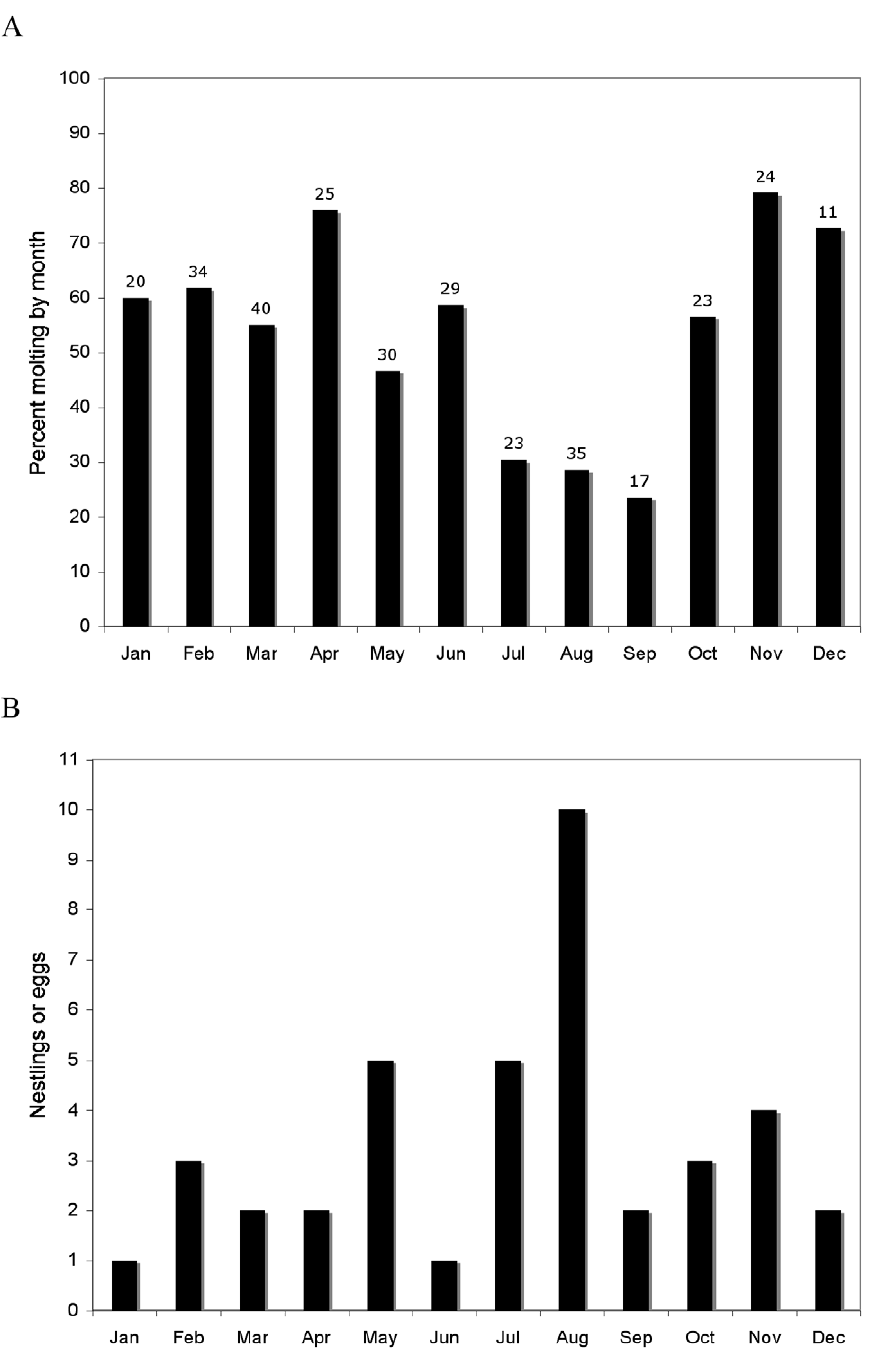
Figure 1. Overlap of molt and breeding in Hemiprocnemystacea at the population level. A is the monthly percentage of birds molting primaries (numbers over bars are sample sizes). B is the number of active nests per month for the 40 breeding records we could find.